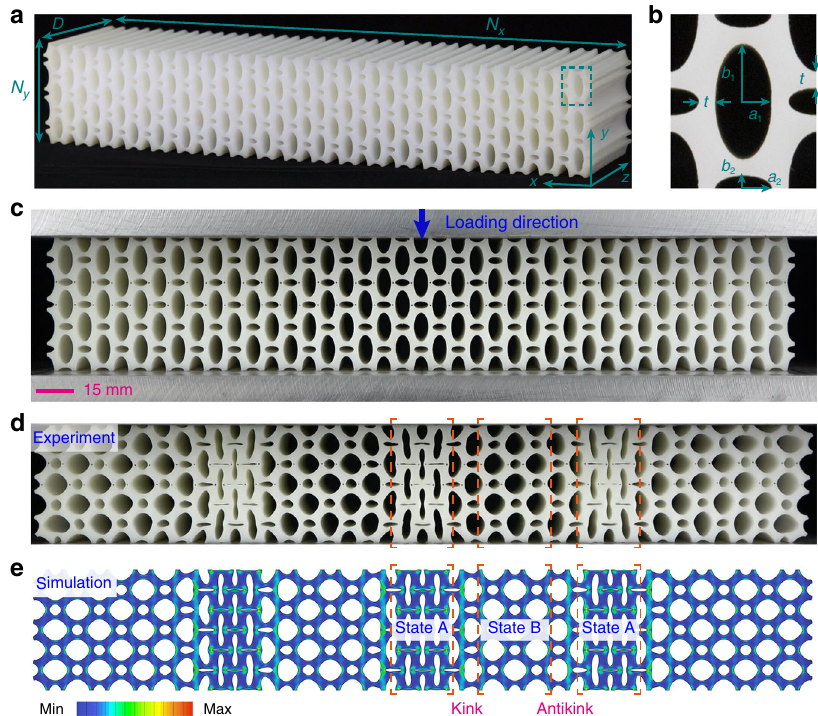
Fig. 1 Structural phase transitions in a mechanical metamaterial lead to static soliton formation. a A rubber metamaterial patterned with a regular array of elliptic holes. b The geometric parameters of the unit cell, here characterized by elliptical-axes a 1 ¼ a 2 ¼ 3 mm and b 1 ¼ 4 b 2 ¼ 6 mm, and by neck thickness t ¼ 1.5 mm. c Static solitons were activated by compression between two lubricated, parallel plates. d , e Uniform compression induces symmetry breaking, with two distinct buckling states A and B emerging in the experimental ( d ) and numerical ( e ) models. Colors in e illustrate the simulated von Mises stress fi eld in the deformed con fi guration. Static periodic solitons (alternating kinks and antikinks) are localized at the domain walls between two uniform polarization